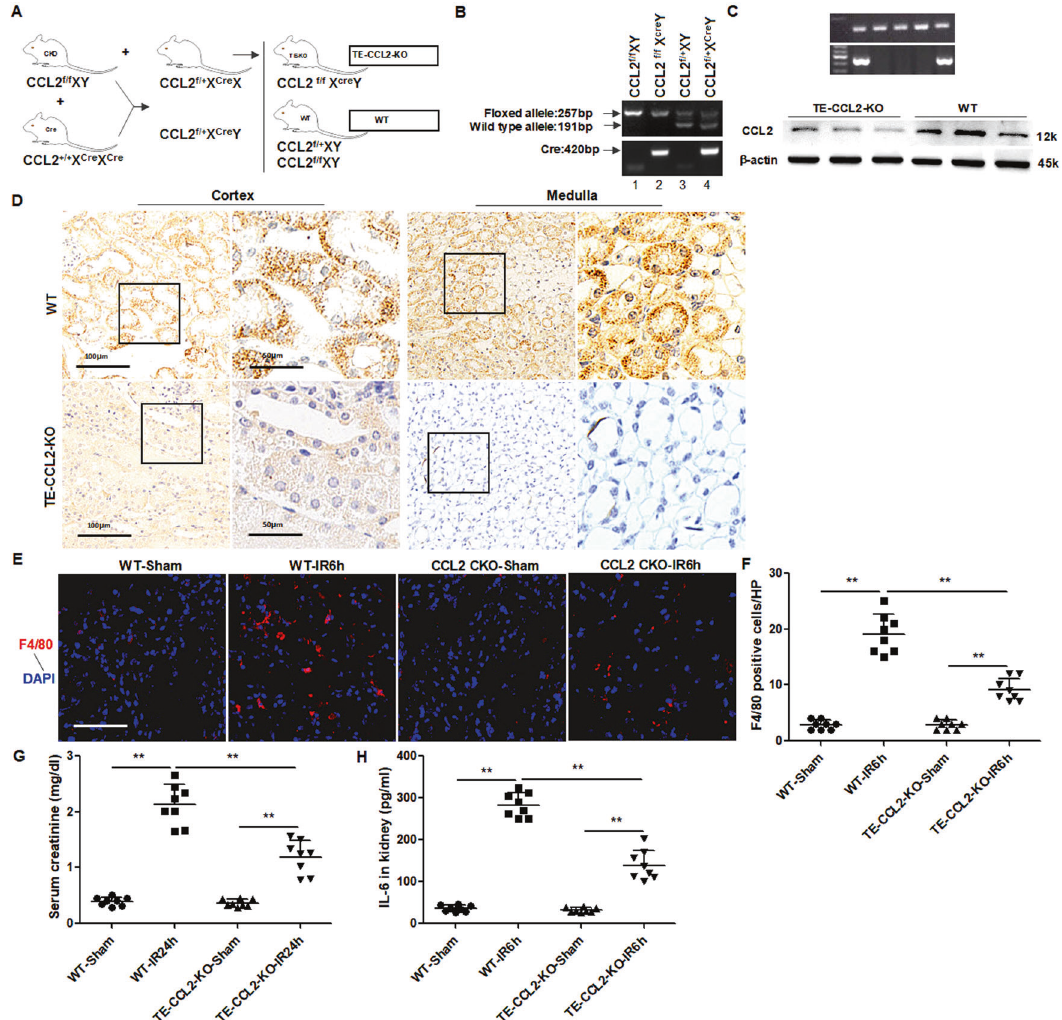
tail and ampli fi ed, wild-type and fl oxed alleles of CCL2 and Cdh16-cre allele were detected. Lane 1 showed the genotyping of the wild-type mice used in this study (CCL2 fl / fl ), lane 2 showed the genotyping of the tubule-speci fi c CCL2 knockout mice (CCL2 fl / fl Cre, designated as